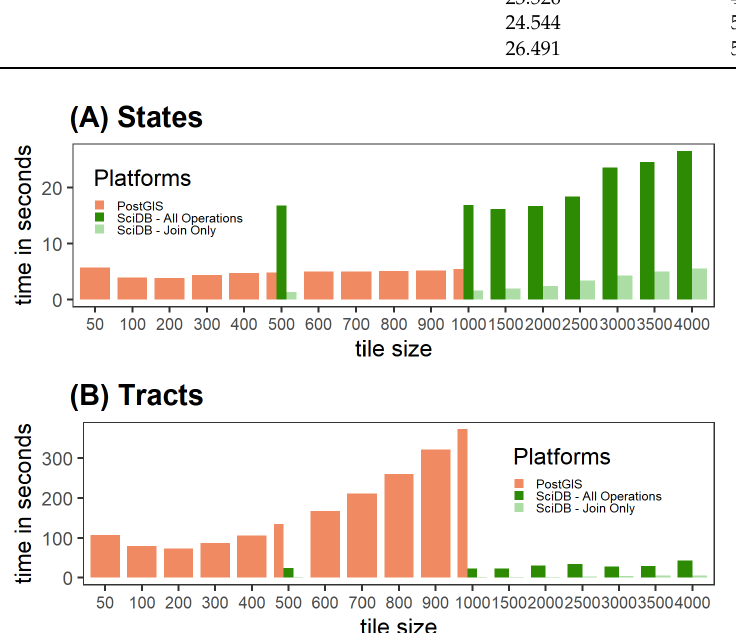
Figure 3. SciDB and PostGIS zonal operator performance time on GLC with states ( A ) and tracts ( B ). Table 10. GeoTrellis zonal operator performance time in seconds on GLC for states and